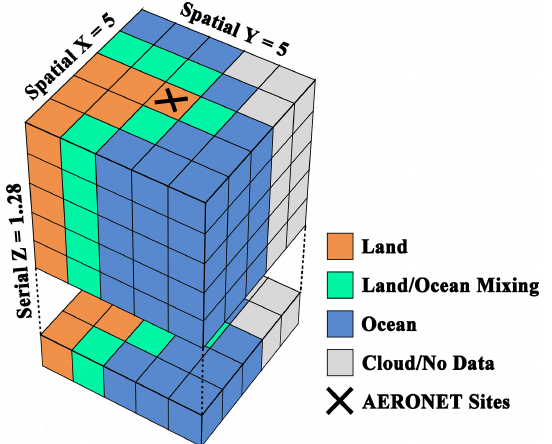
Figure 1. Schematic diagram for multi-pixel retrieval unit (5 × 5 × 1..28). The maximum of 28 sequences allowed in each unit is due to limited hardware